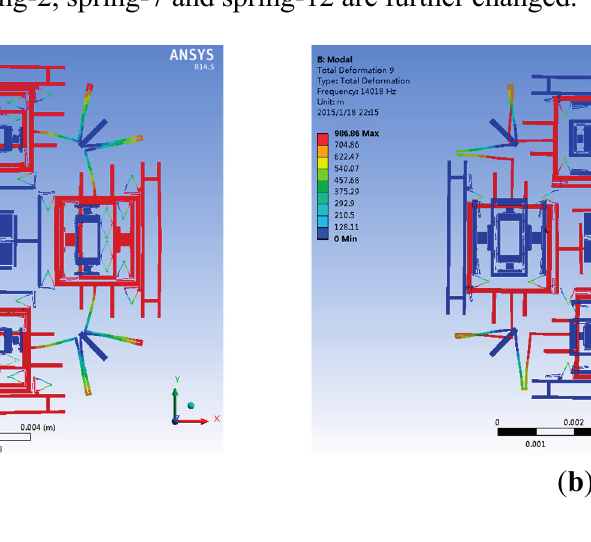
Figure 8. Further mode matching process can be divided into two steps (the changed dimensions are marked in red): ( a ) step 1: length of spring-2, spring-7, spring-11 and spring-12 are adjusted; ( b ) step 2: length of spring-2, spring-7 and spring-12 are further